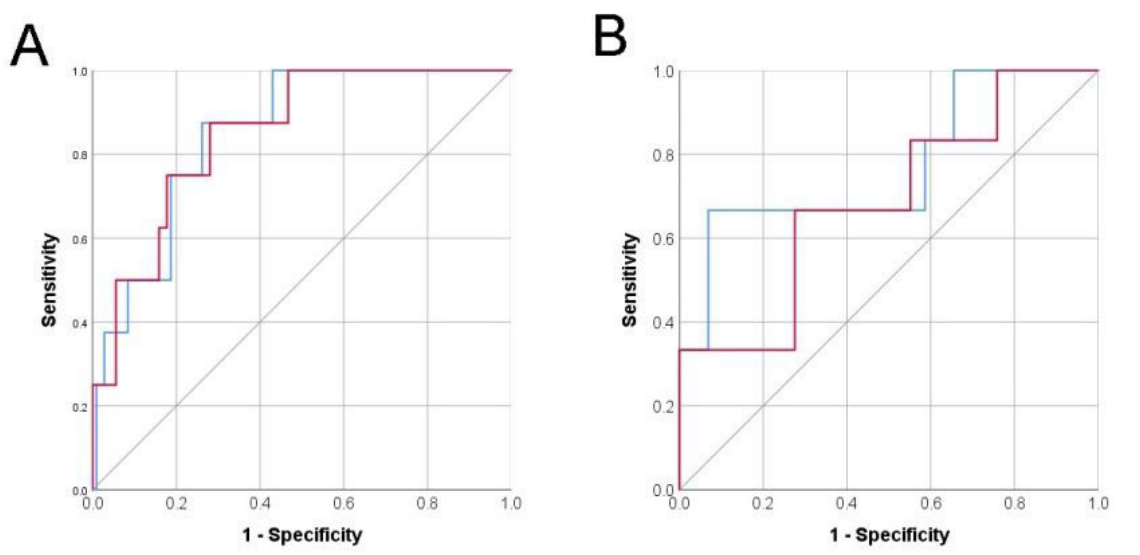
Figure 2. Receiver operating curve analysis with ( A ), blue line, area under curve = 0.850, 95% CI = 0.744–0.957, p < 0.001, ( B ), blue line, area under curve = 0.770, 95% CI = 0.0534–1.000, p = 0.040) or without ( A ), red line, area under curve = 0.850, 95% CI = 0.737–0.964, p < 0.001, ( B ), red line, 0.690, 95% CI = 0.448–0.931, p = 0.149) intra- and post-operative variables in the development ( A ) and validation ( B )